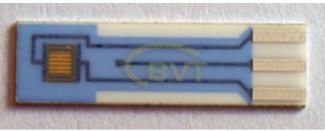
Figure 1. Conductometric sensor support from BVT Technologies company.